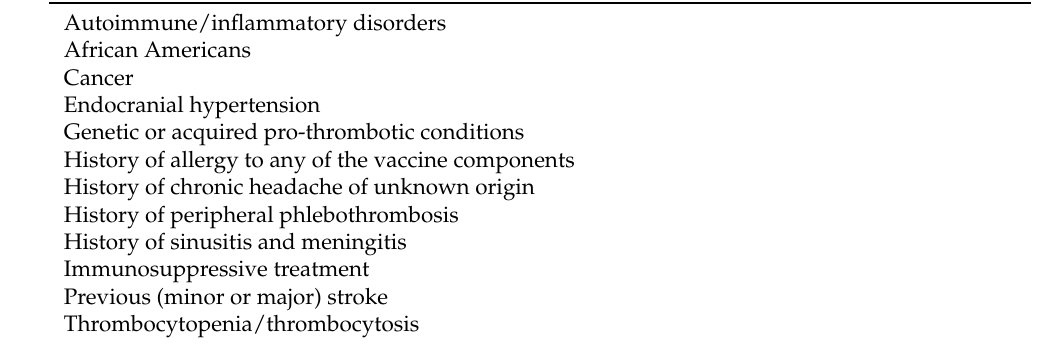
Table 3. Predisposing conditions for CVST to consider in people undergoing (adenoviral vector) vaccination (based on former